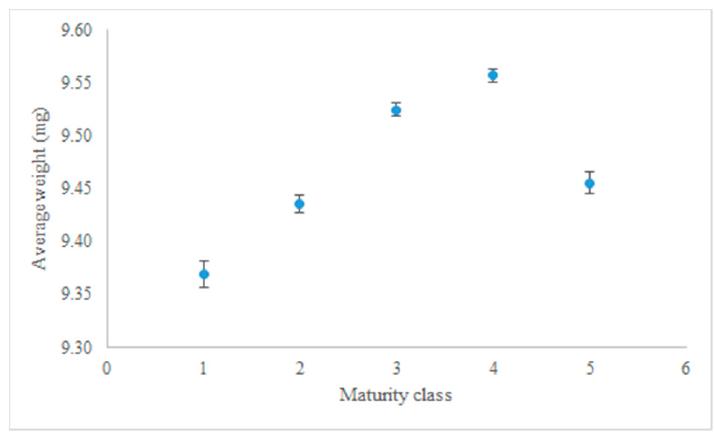
Agronomy 2019 , 9 , x FOR PEER REVIEW